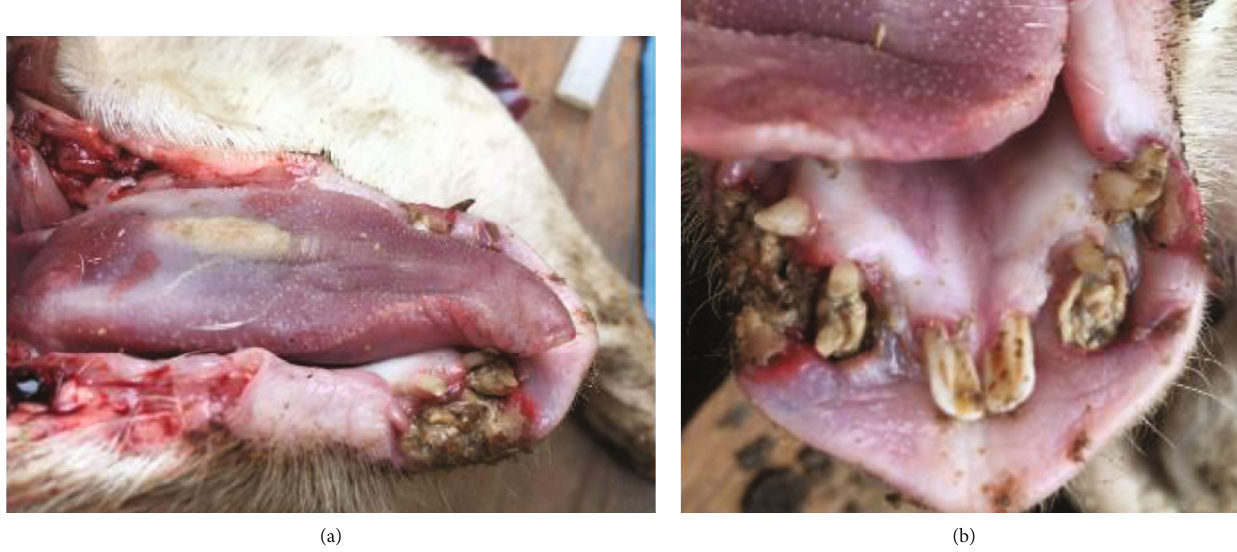
Figure 1: Suckling piglet. Gross pathology. A large lesion ( 2 × 1 : 5 cm) was seen on the inner surface of the lower lip, close to the 2 nd and 3 rd right incisors. The lesion was ulcerated and protruded onto the surface of the oral mucosa (a). Ulcerated and smaller lesions were additionally detected close to the 2 nd and 3 rd left incisors